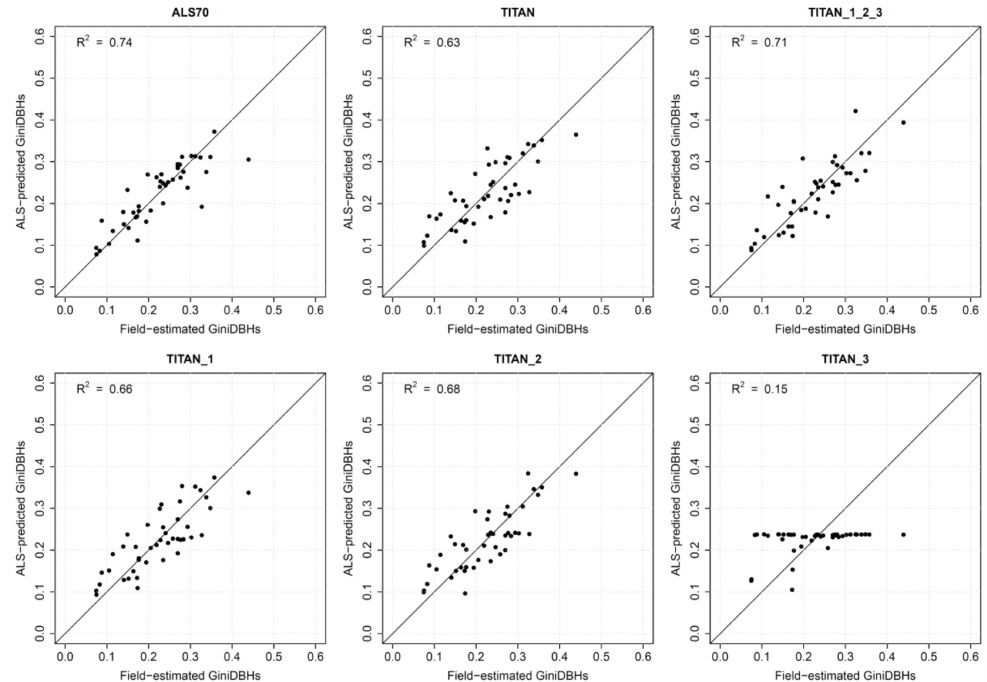
Figure 5. Scatterplots of the field-estimated and ALS-predicted values of Gini coefficient of DBHs ( GiniDBHs ) for each sub-plot for each model. In each scatterplot the Pearson’s correlation coefficient between observed and predicted values is shown.